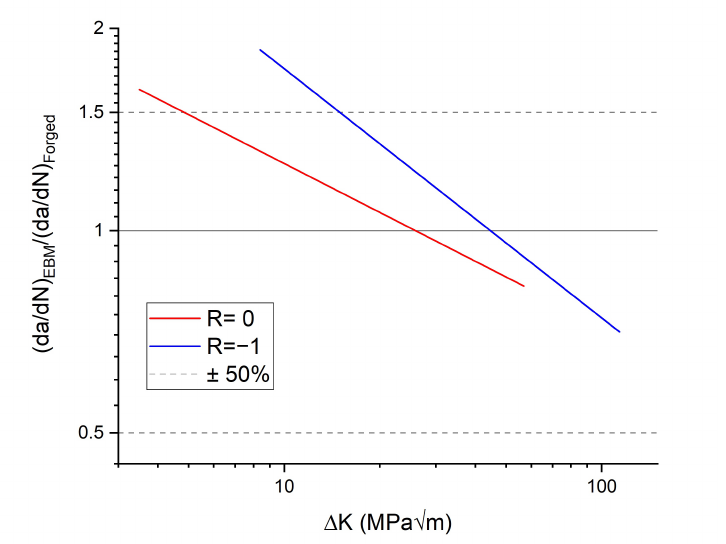
Figure 5. Comparison between the Paris descriptions of crack propagation data from electron beam melting (EBM) produced and forged Ti-6Al-4V for two stress ratios, R = 0 and R = − 1. As the input parameter in NASGRO, the depth parameter a was used. a was defined as the distance from the furthest edge of the initiating defect to the specimen surface ( a = h + r in Figure 3). Only uniform stress was considered. The loads used for the FCG calculations of the strain controlled R = − 1 specimen were taken from the empirical mid- life cycle loads. A comparison with calculations using true loads was made with negligible difference in predicted life. For failure evaluation, the net-section stress failure criterion in NASGRO was disabled. Instead, the calculations ended when the calculated maximum √ mm , the same stress intensity factor exceeded the fracture toughness ( K c ) set to 1799 MPa as the forged reference material. A similar fracture toughness has been reported for as-built EBM produced Ti-6Al-4V by Galarraga et al. [41]. Seifi et al. [18] reported a higher fracture toughness, but also a large variation within single builds, motivating the use of the more conservative